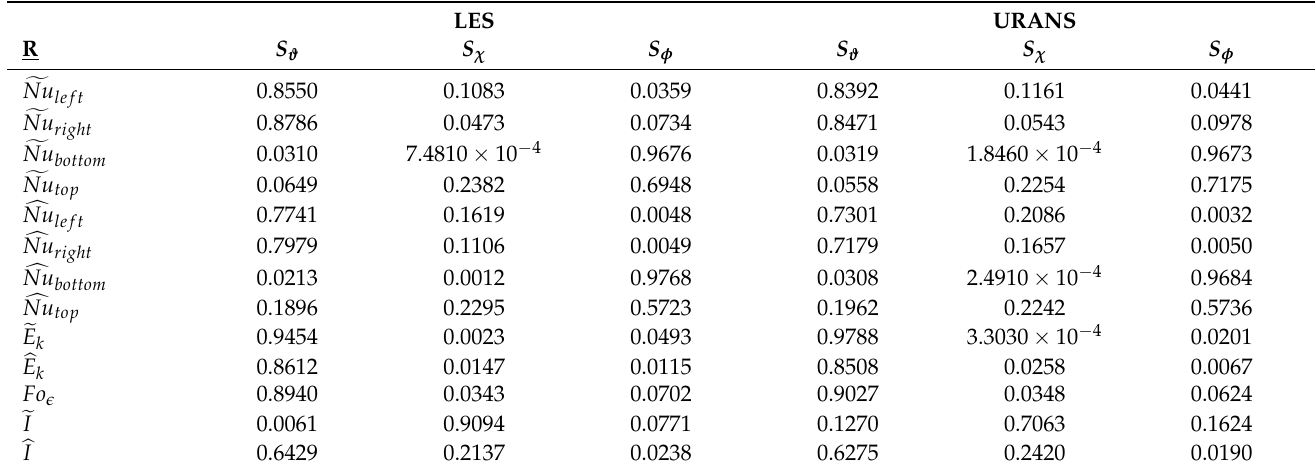
for the random response R . i